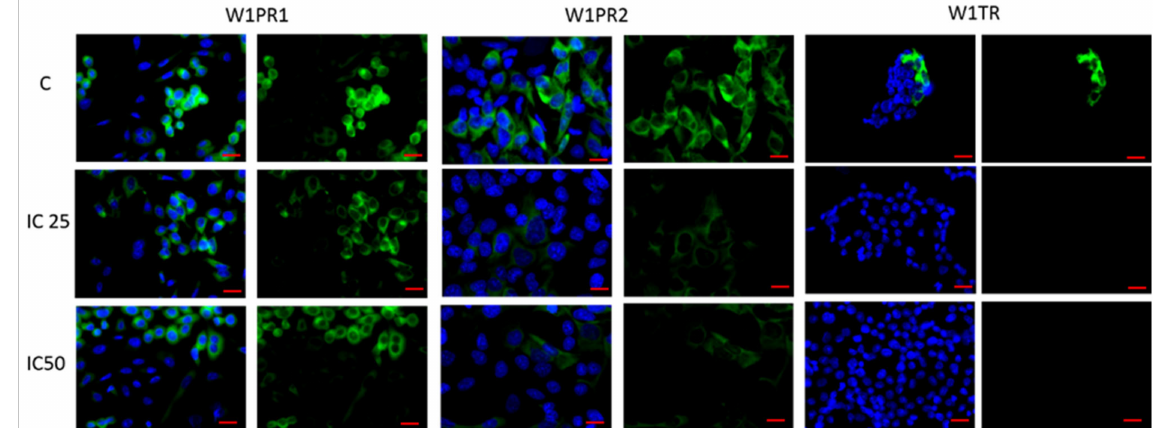
Figure 4. Immunofluorescence visualization of ALDH1A1 expression in PAC and TOP resistant cell lines after piperine treatment. ALDH1A1 was detected using the anti-ALDH1A1 antibody and an Alexa Fluor ® 488-conjugated secondary antibody (green). Cell nuclei were stained with DAPI (blue). Row C shows the control state (cells without piperine), IC25 and IC50 show the cells treated with piperine for 72 h. The first column shows both DAPI (blue) and target protein signal (green), the second column shows the target protein signal alone. Scale bar = 2- µ m.